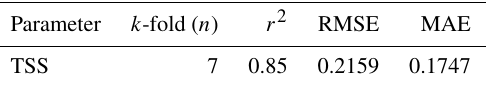
Table 3. Assessment of fitting error for the proposed TSS model, using k -fold cross